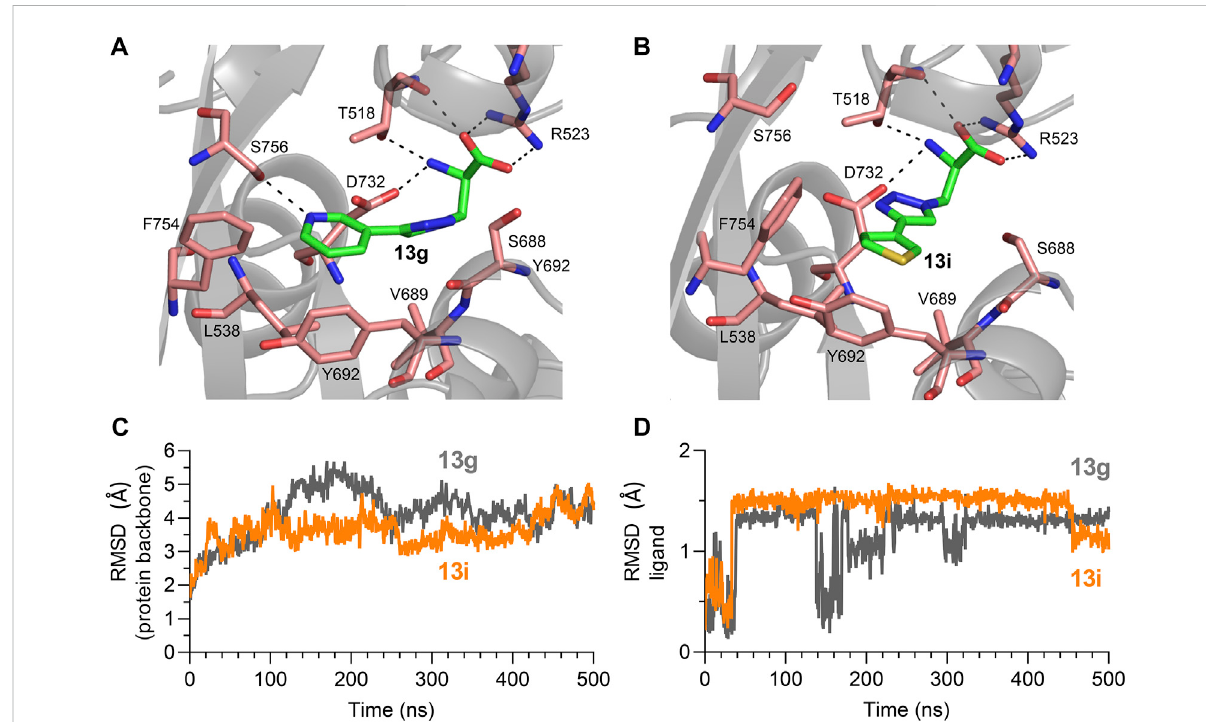
FIGURE 5 (A,B) Most abundant binding mode of 13g and 13i in the Gly binding site of GluN1 during molecular dynamics simulation from in initial docking model. (C,D) RMSDofproteinbackboneandligandcomparedtotheinitialdockingmodelformoleculardynamicssimulationswith 13g (grey)and 13i